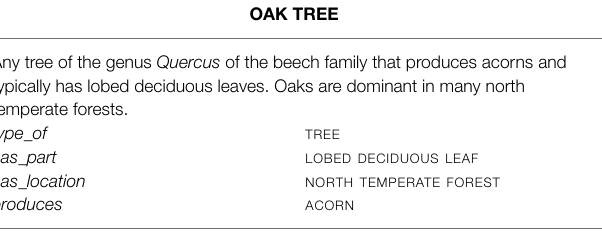
TABLE 2 | O ak tree definitional template after the application of the tree definitional template. OAK TREE